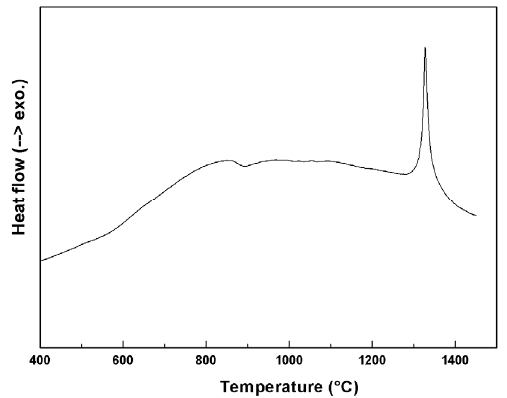
Fig. 1 DTA curve of the powder mixture of Ti and